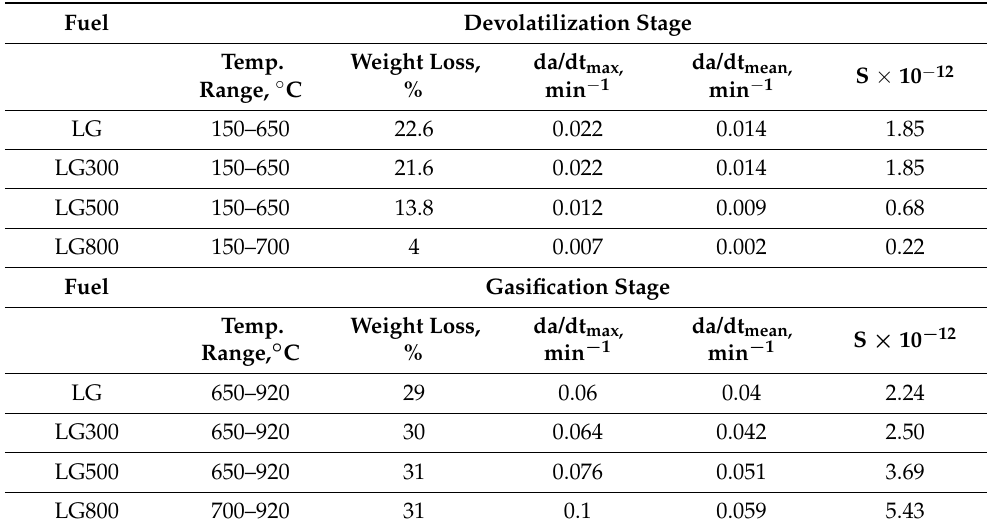
Table 2. Characteristic parameters of pyrolysis and gasification stages during non-isothermal ther- mogravimetric analysis under pure CO 2